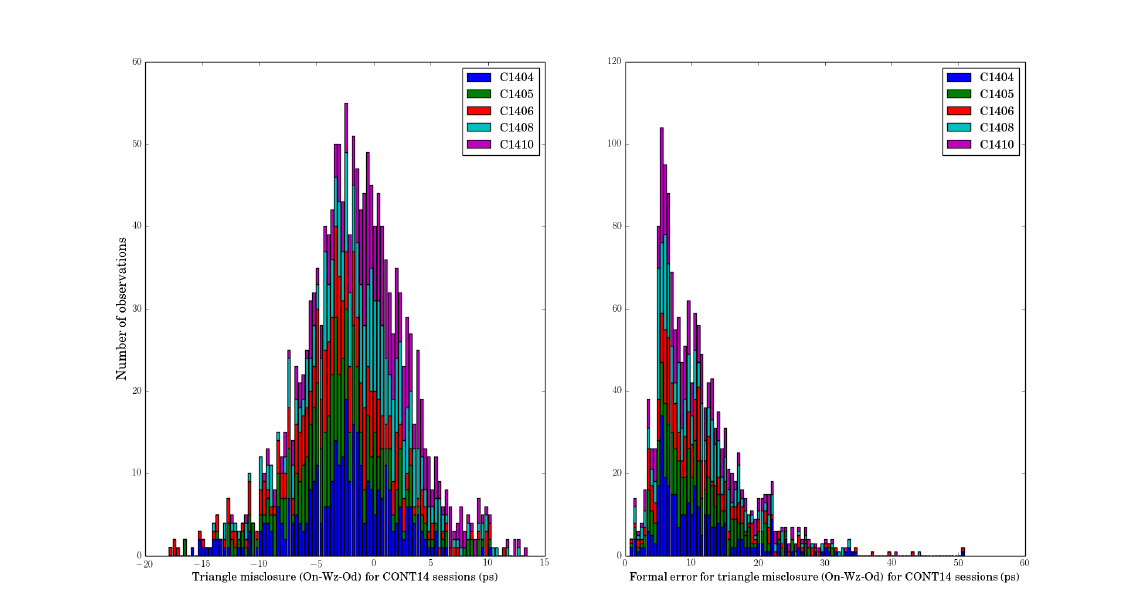
Figure 4: Histograms of the misclosures in the triangle (On-Wz-Od) for the five CONT14 sessions (left plot) and the corresponding formal errors (right plot). The median absolute values are 6.5 and 3.2 ps for the misclosures and the formal errors,